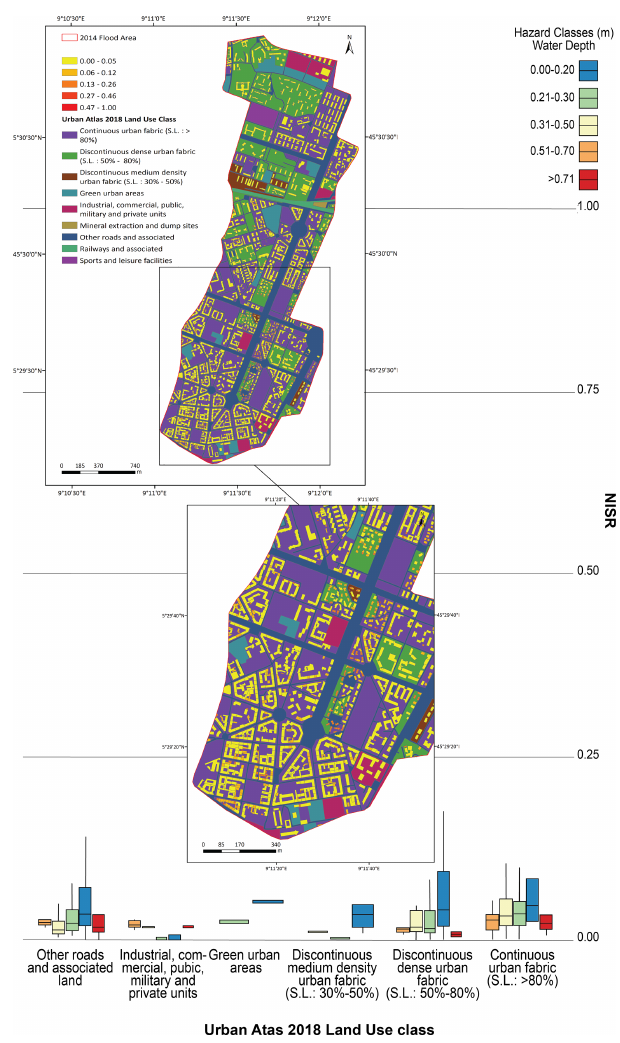
Figure 5. Boxplots and maps of NISR distribution for residential buildings according to Urban Atlas 2018 land-use classes and wa- ter depth hazard classes. Built-up-area shapefile is from © Open- StreetMap contributors 2022. Distributed under the Open Data Commons Open Database License (ODbL) v1.0. Base map is from © European Union, Copernicus Land Monitoring Service 2022, Eu- ropean Environment Agency